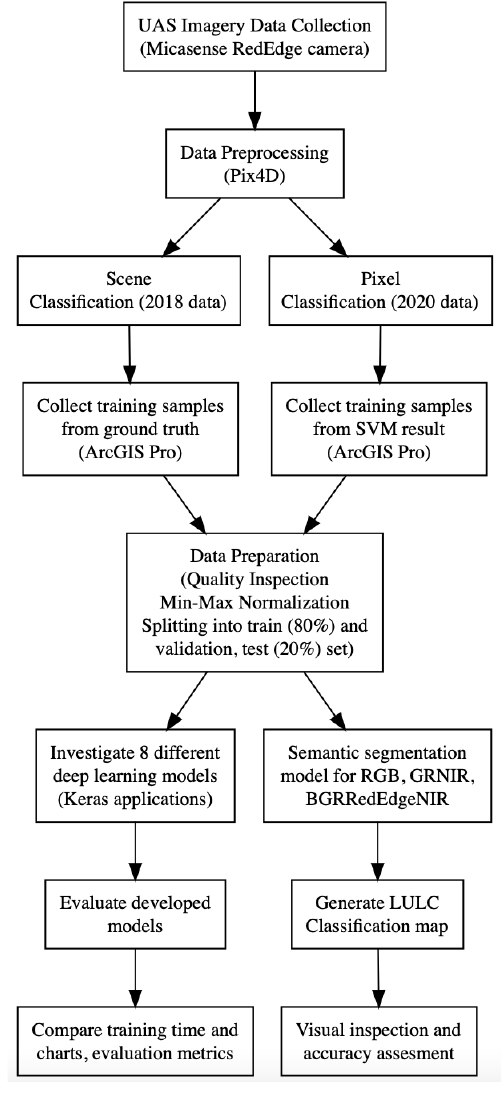
Figure 1: Research Methodology / Workflow The raw data from the Micasense RedEdge camera was processed using Pix4D Mapper, in order to generate an orthomosaic imagery. This was followed by the process of collecting training samples for both scene-based and pixel- based classification methods. Training samples were collected